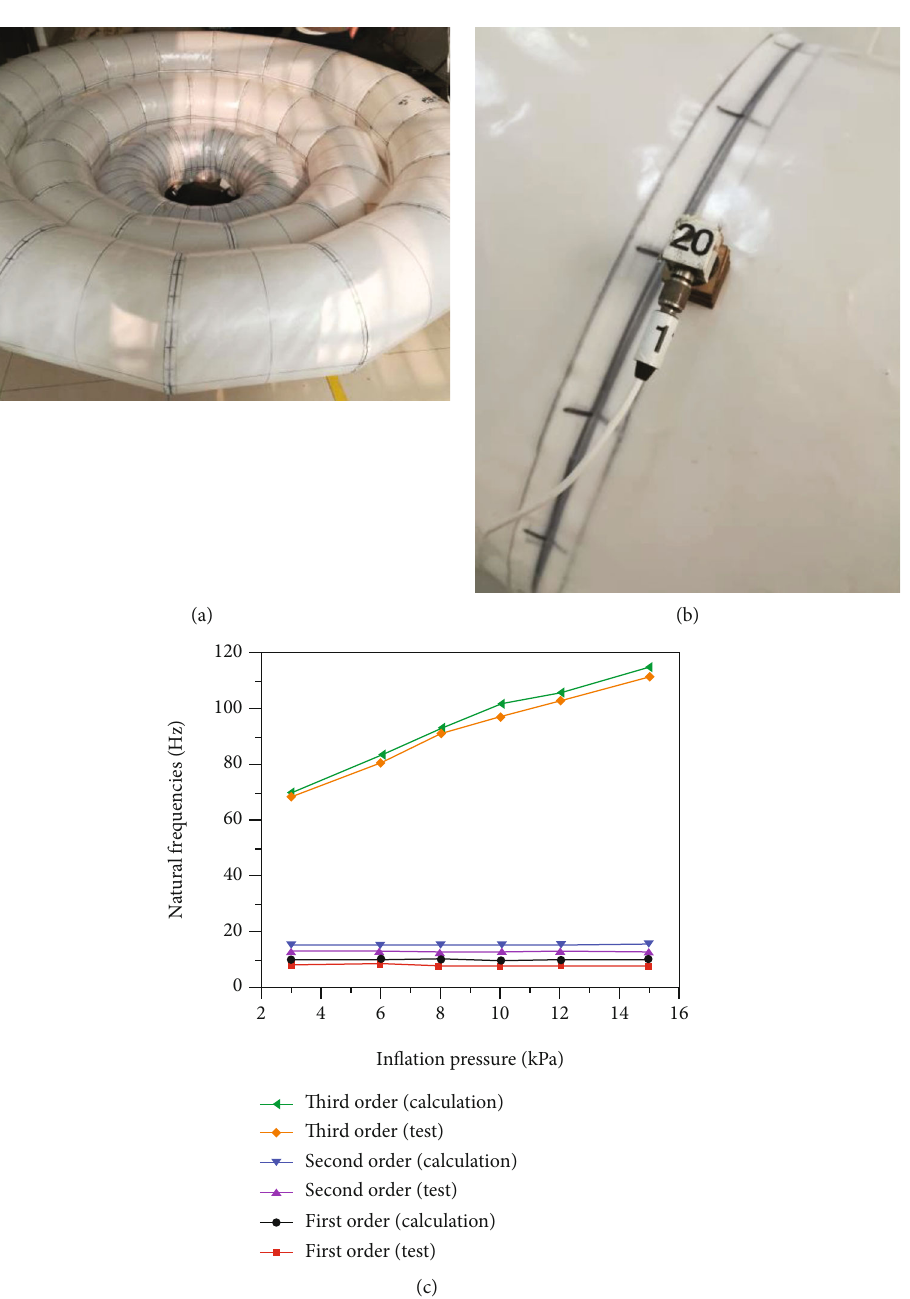
Figure 4: Modal test and results: (a) structure of modal test; (b) sensor layout; (c) validation of structural dynamic